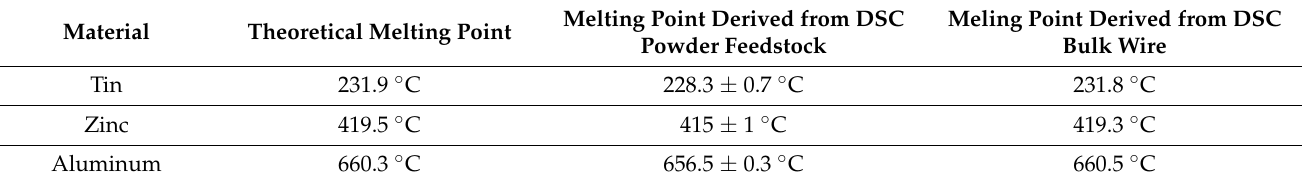
Table 1. DSC melting point